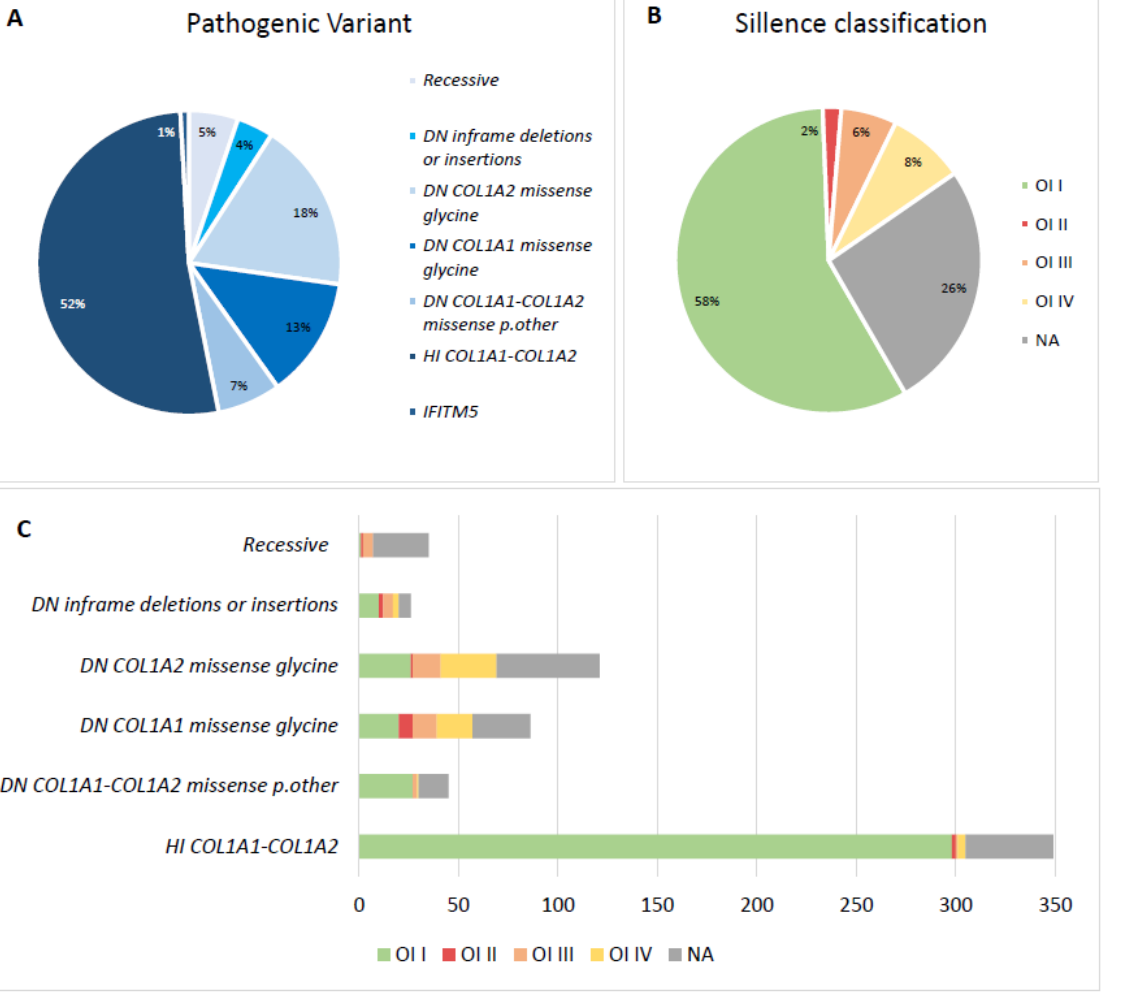
Figure 1. ( A ) The distribution of pathogenic variants found in the Dutch OI cohort. ( B ) The distribu- tion of Sillence classification types in the Dutch OI cohort. ( C ) Combined overview of the Sillence classification type and pathogenic variants found in the Dutch OI cohort A match between the Amsterdam UMC Genome Database cohort and the CBS cohort